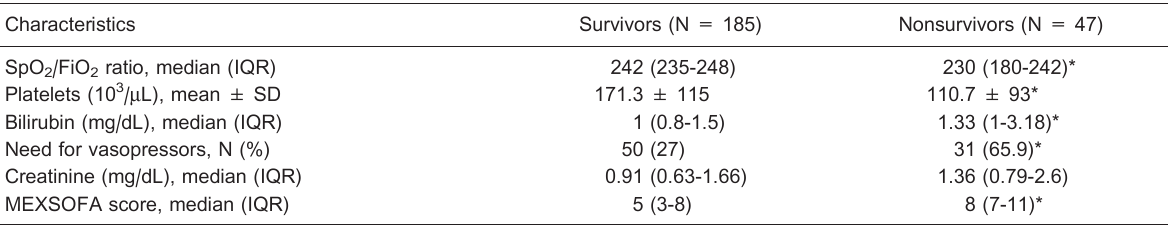
Table 5. Variables of the Mexican sequential organ failure assessment (MEXSOFA) at 48 h of admission to the intensive care unit according to outcome.